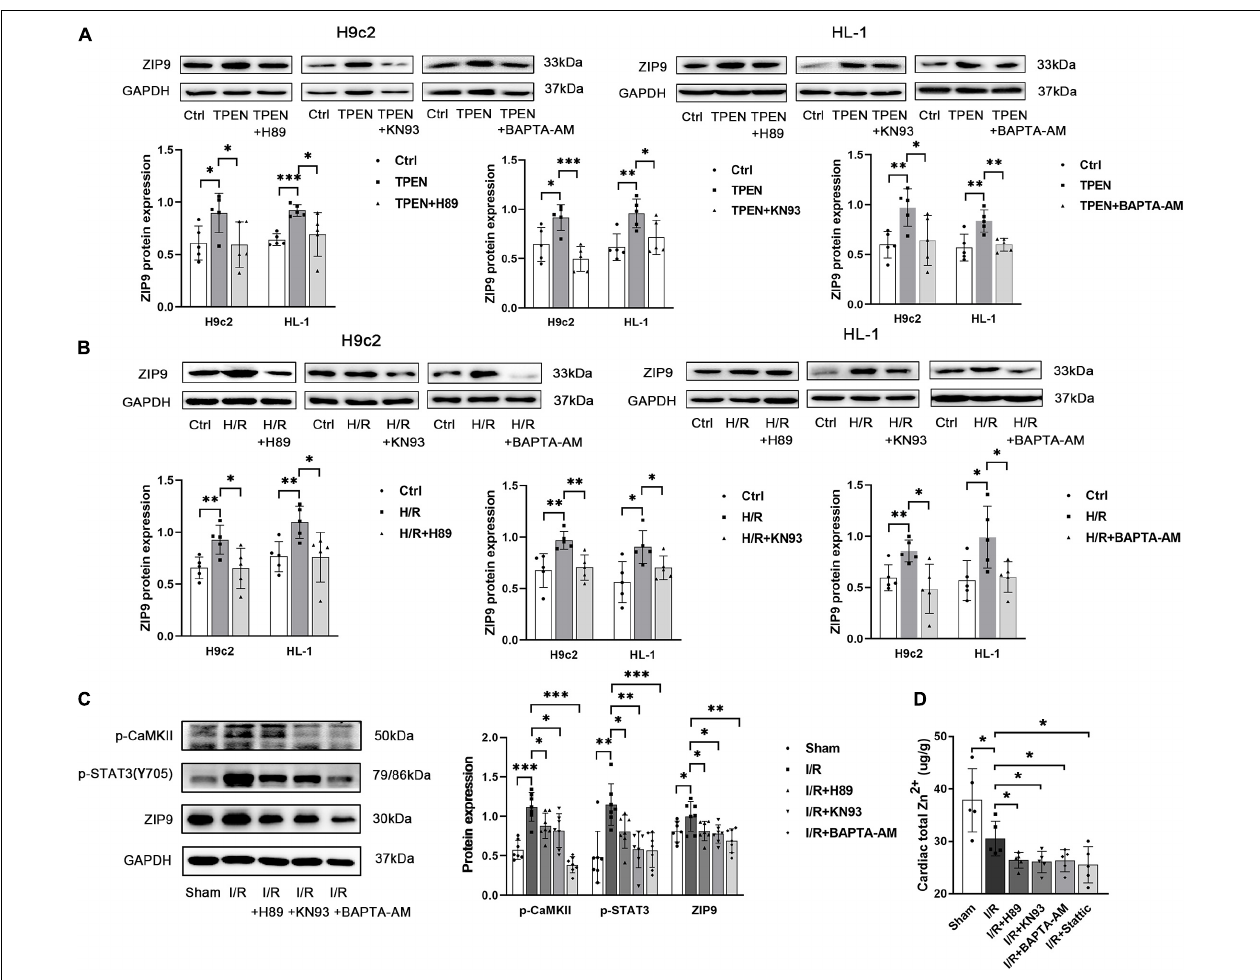
FIGURE 6 | ER Stress/CaMKII is involved in the regulation of ZIP9 by STAT3 (A,B) H89, KN93, or BAPTA-AM (10 µ M, n = 5) were applied 2 h before exposure to TPEN for 2 h or 30 min before the onset of reoxygenation. (C) Mouse hearts were ischemic for 30 min and then reperfused for 30 min. H89, KN93 or BAPTA-AM (10 mg/kg) were injected 5 min before reperfusion and continued for 30 min through the tail vein ( n = 7). (D) Zn 2 + levels were monitored with inductively coupled plasma optical emission spectroscopy (ICPOES, n = 5). ∗ p < 0.05, ∗∗ p < 0.01, and ∗∗∗ p <